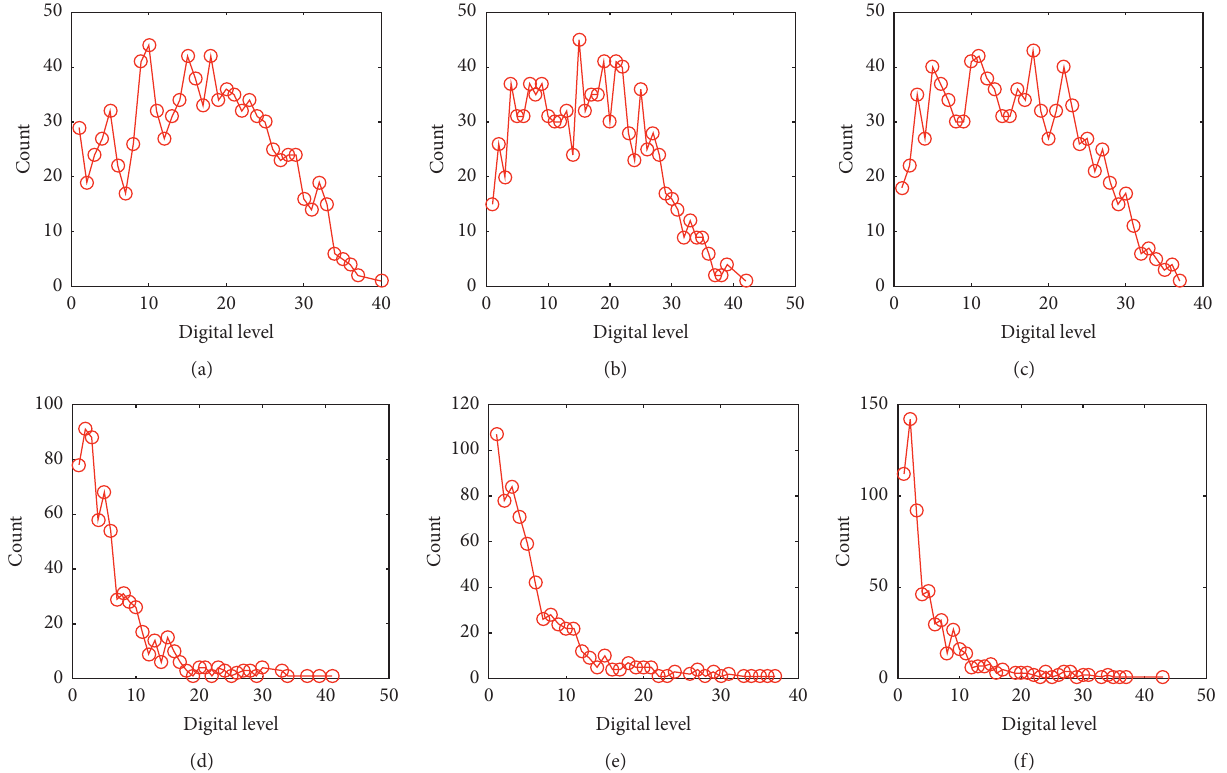
Figure 12: The digital levels of enterprises under different environmental policies: (a) pr � 0.3, Cu � 1, Cb � 2; (b) pr � 0.5, Cu � 1, Cb � 2; (c) pr � 0.7, Cu � 1, Cb � 2; (d) pr � 0.3, Cu � 2, Cb � 4; (e) pr � 0.5, Cu � 2, Cb � 4; (f) pr � 0.7, Cu � 2, Cb � 4.